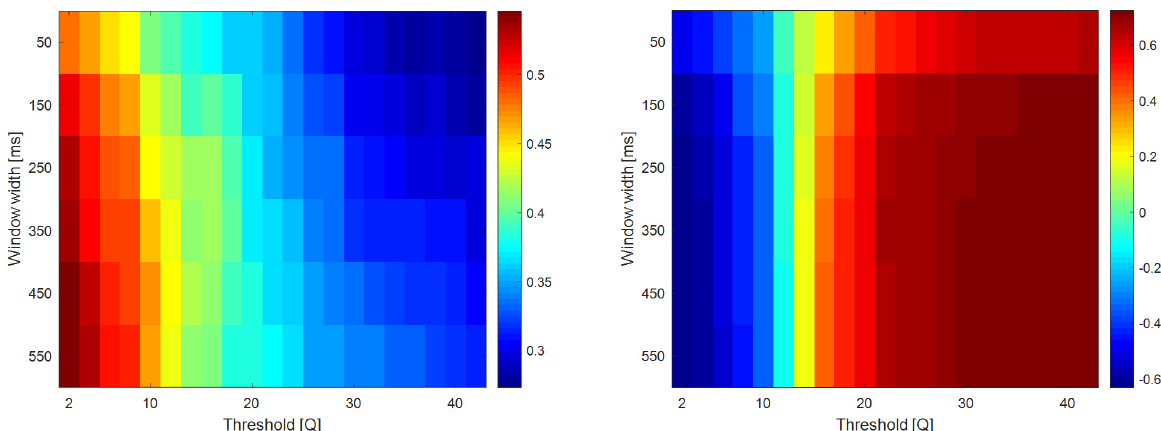
Figure A10. RMSE ( left ) and cross-correlation ( right ) for ZC with different thresholds (Q multipliers